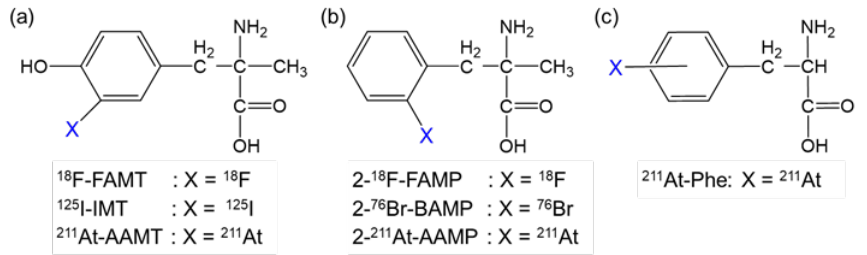
Figure 1. Structure of radiohalogen-labeled amino acids targeting LAT1. Radiohalogen-labeled ( a ) α-methyl-L-tyrosine, ( b ) α-methyl-L-phenylalanine, and ( c ) L-phenylalanine derivatives.